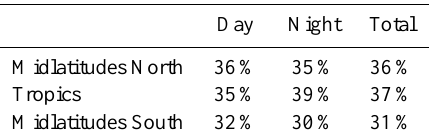
Table 2. Cirrus clouds cover obtained from the reduced database,